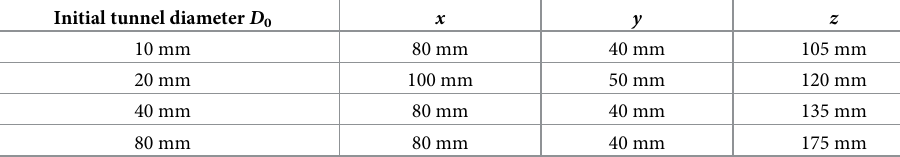
Table 1. Size of experimental containers